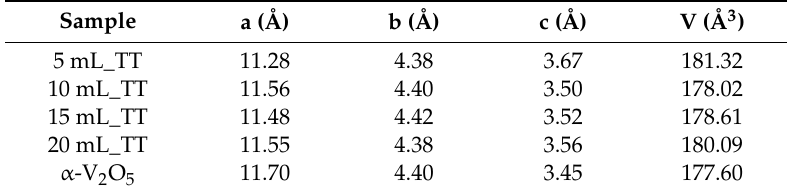
Table 1. The lattice parameters of the unit cell a, b, and c and its volume derived from the Bragg’s relation for each sample. In addition, the lattice parameters of the α -V 2 O 5 were